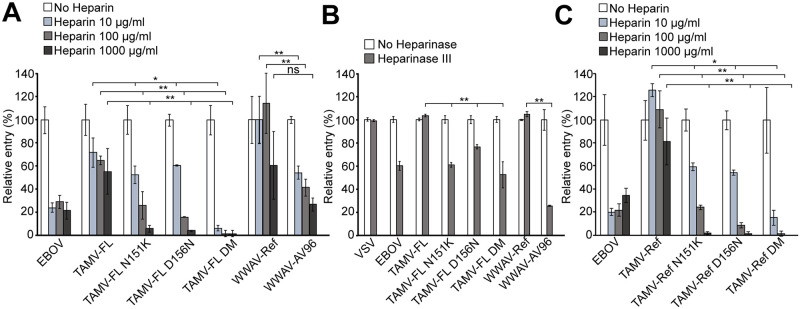
HSPG binding modulation by N151K and D156N substitutions.(A) Relative entry of TAMV-FL mutants in infections performed in presence of increasing concentrations of heparin. Error bars represent standard deviations (n = 4). (B) Relative entry of PV infections performed in heparinase III-A549-treated cells. Error bars represent standard deviations (n = 4). (C) Relative entry of TAMV-Ref mutants in infections performed in presence of increasing concentrations of heparin. Error bars represent standard deviations (n = 4). Asterisks in all panels denote statistical significance in ANOVA test (ns: p>0.05; *: p<0.05; **: p<0.01).